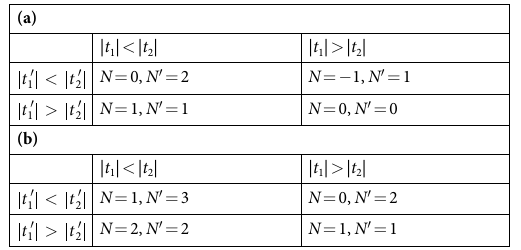
Table 1. The winding numbers associated with the two chiral symmetries: (a) the case of two Majorana chains;